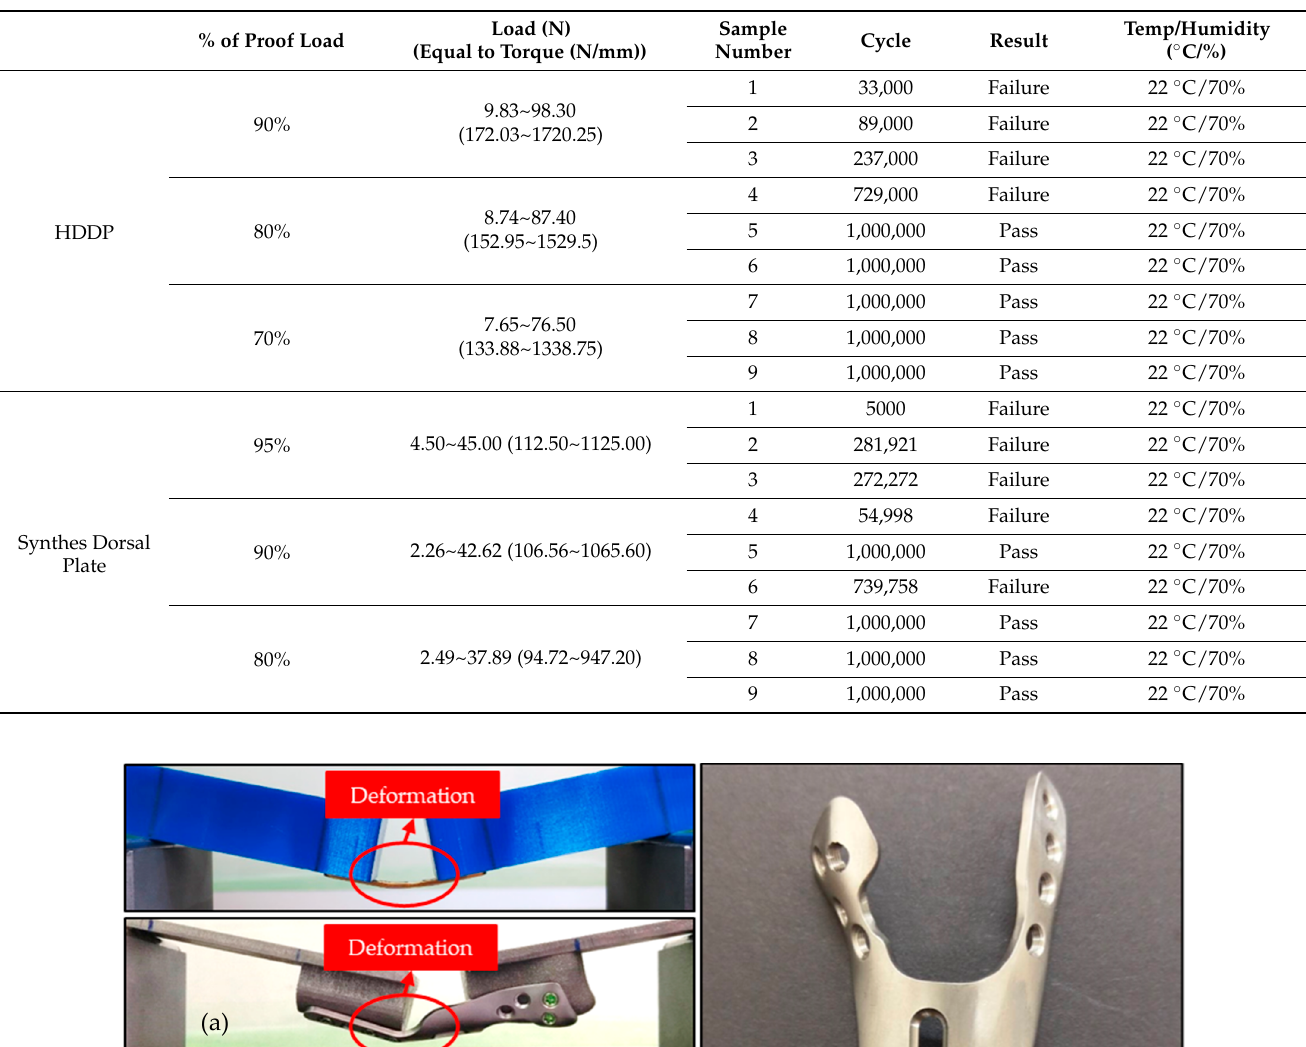
Table 1. Fatigue four-point bending test results for HDDP and DDP.